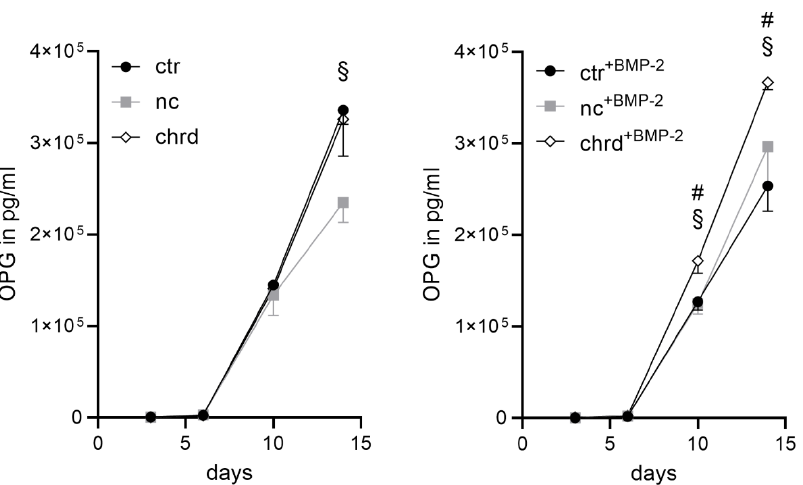
Figure 9. Osteoprotegerin (OPG) in the supernatant during supplement-free co-culture of hMSC (human mesenchymal stem cells) and hPBMC (human peripheral blood mononuclear cells) seeded on a decellularized mineralized matrix with pre-differentiated microtissues (ctr: non-treated control, nc: non-coding siRNA, chrd: chordin siRNA). Statistically significant differences ( p < 0.05) between ctr and chrd are indicated with (#), between nc and chrd with (§).